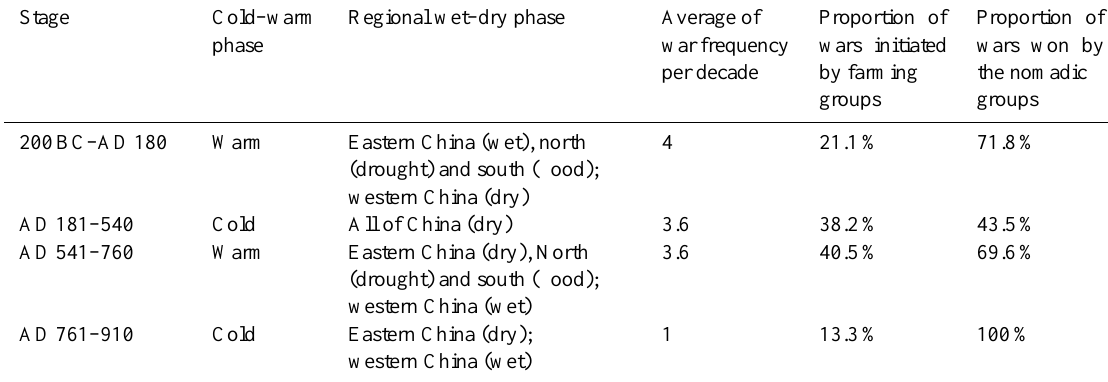
Table 3. Ethnic wars in cold and warm periods on a centennial timescale.